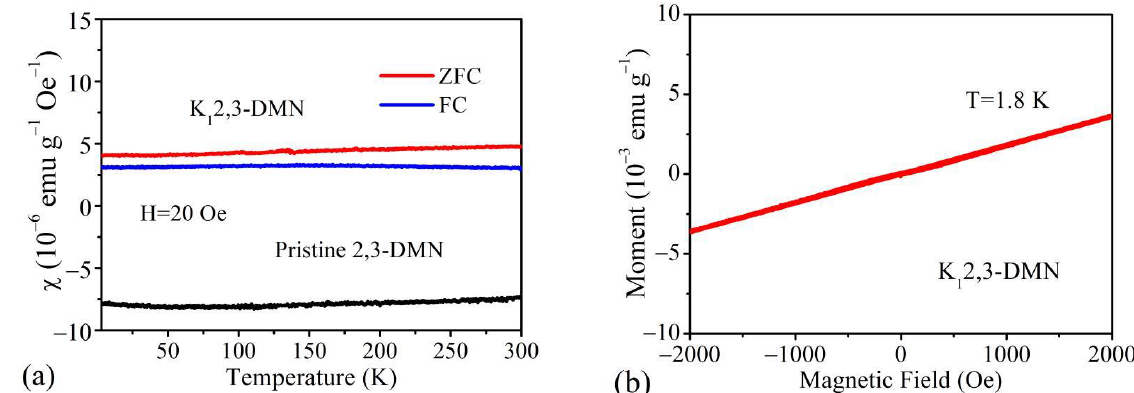
Figure 4. ( a ) The temperature dependence of the magnetic susceptibility χ for pristine and potassium-doped 2,3-DMN sample in the temperature range of 1.8 K to 300 K. ( b ) The magnetization loops for potassium-doped 2,3-DMN sample at temperature of 1.8 K.